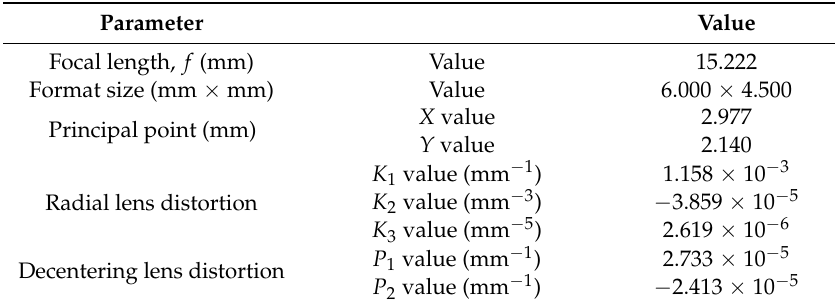
Table 2. Interior orientation parameters of thermographic camera, NEC TH9260, resulting from its geometric calibration.